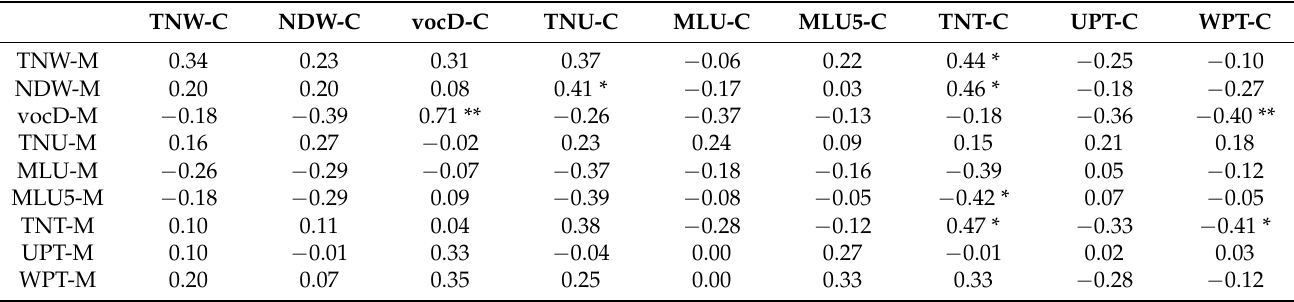
Table 4. Spearman’s rank correlations between the interactive language of mothers (-M) and children with ASD